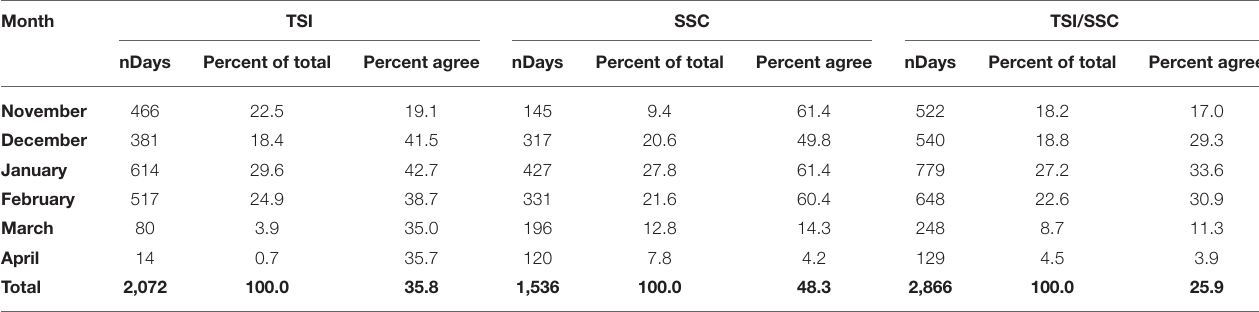
TABLE 1 | For lake-effect days identified by the TSI method, SSC method, and the methods combined (TSI/SSC), the monthly distribution, the percentage of seasonal days occurring within each month, and the percentage of days each month that are supported by the other method (TSI, SSC), or by both methods (TSI/SSC), 1964–65 through 2014–15.